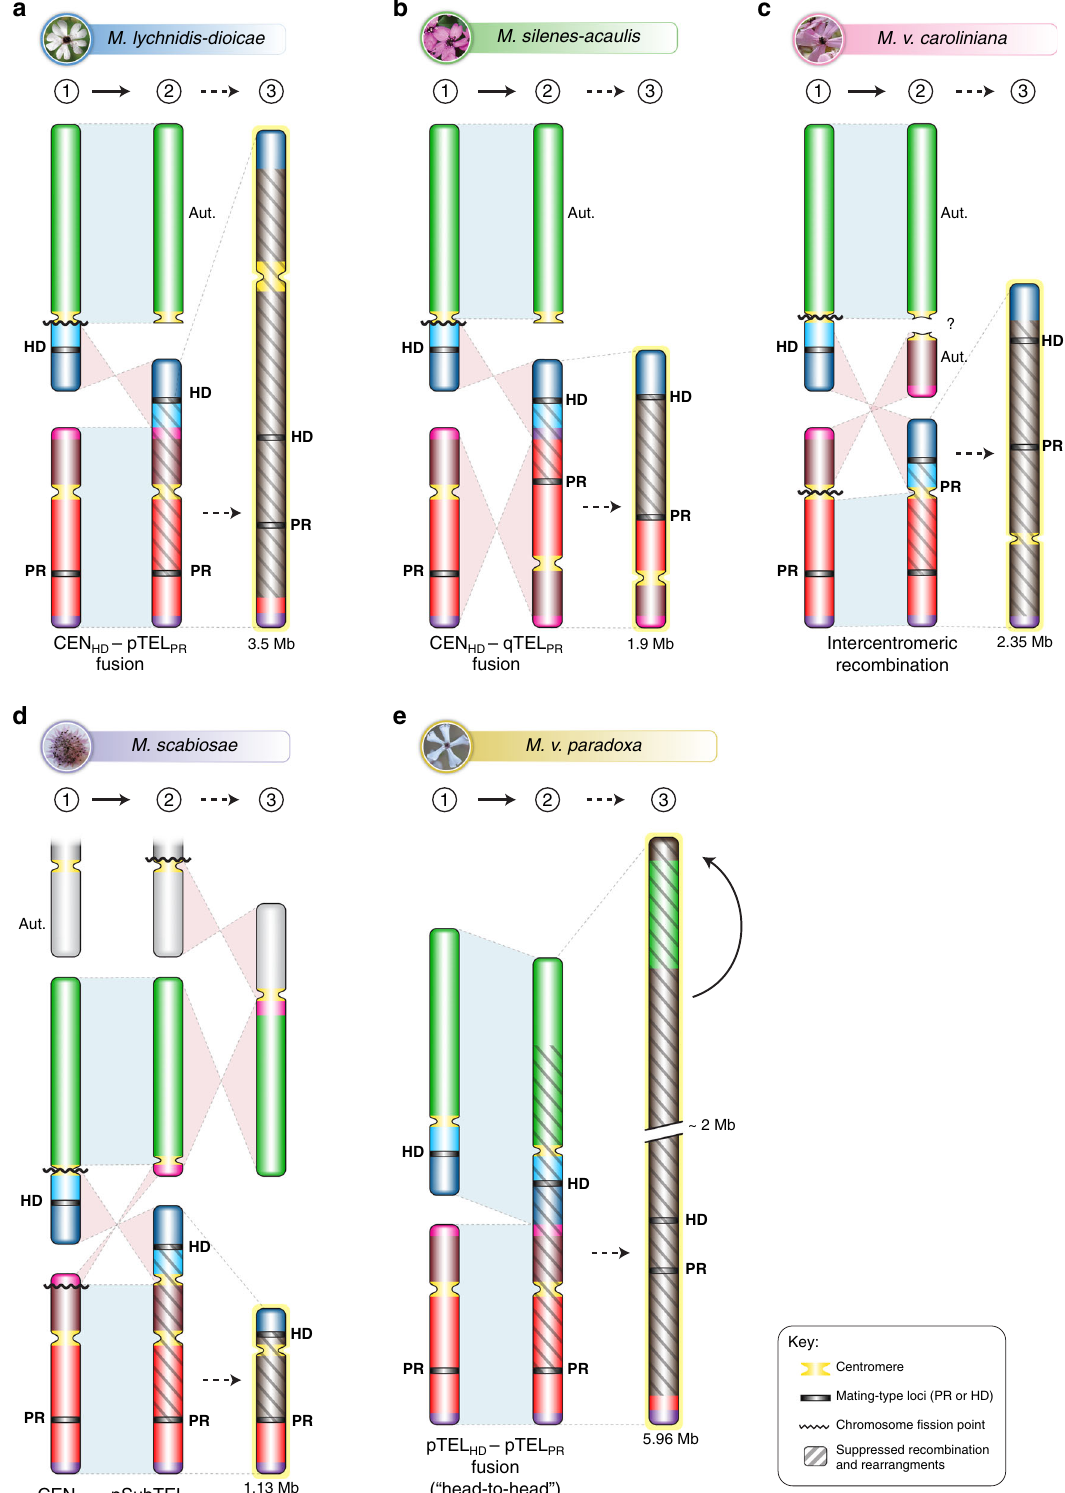
Key: Centromere Mating-type loci (PR or HD) Chromosome fission point Suppressed recombination and